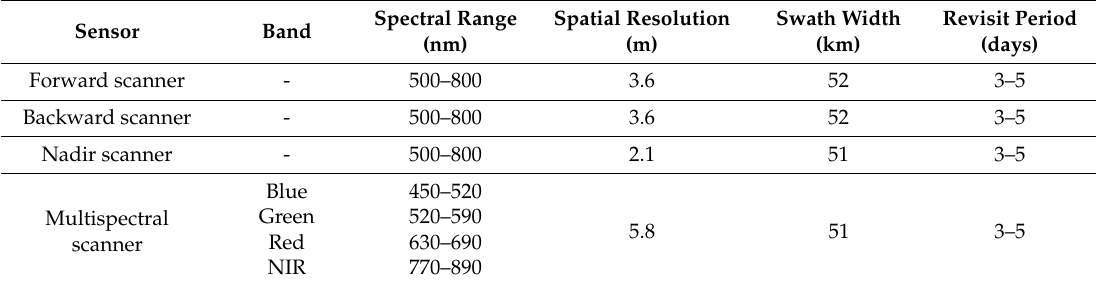
Table 2. Primary characteristics of